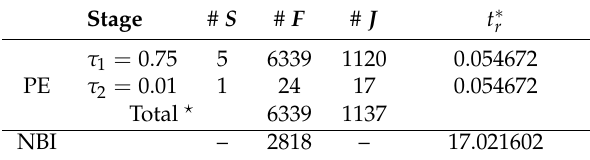
Figure 10. Numerical results for the first run with the C-convDTLZ2 problem. Table 6. Numerical results for the second run with the